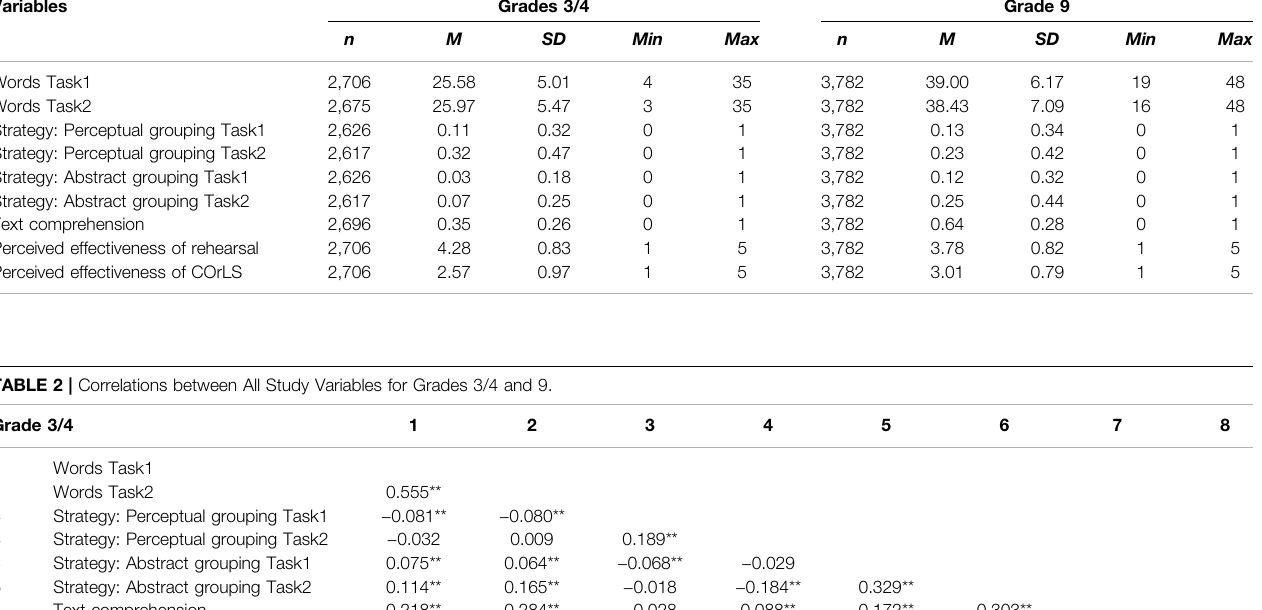
TABLE 1 | Descriptives of All Study Variables for Grades 3/4 and 9. Variables